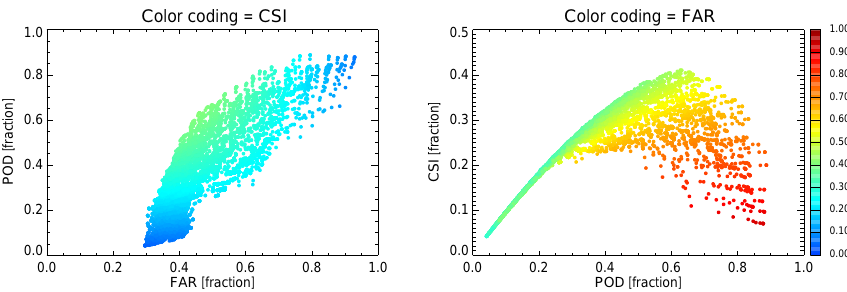
Figure 3. Probability of detection (POD) as a function of the false acceptance rate (FAR) and critical success index (CSI) as a function of the POD for different definitions of the MSG-CPP high IWC mask definitions and their success in detecting high IWC values in DARDAR IWC profile data.